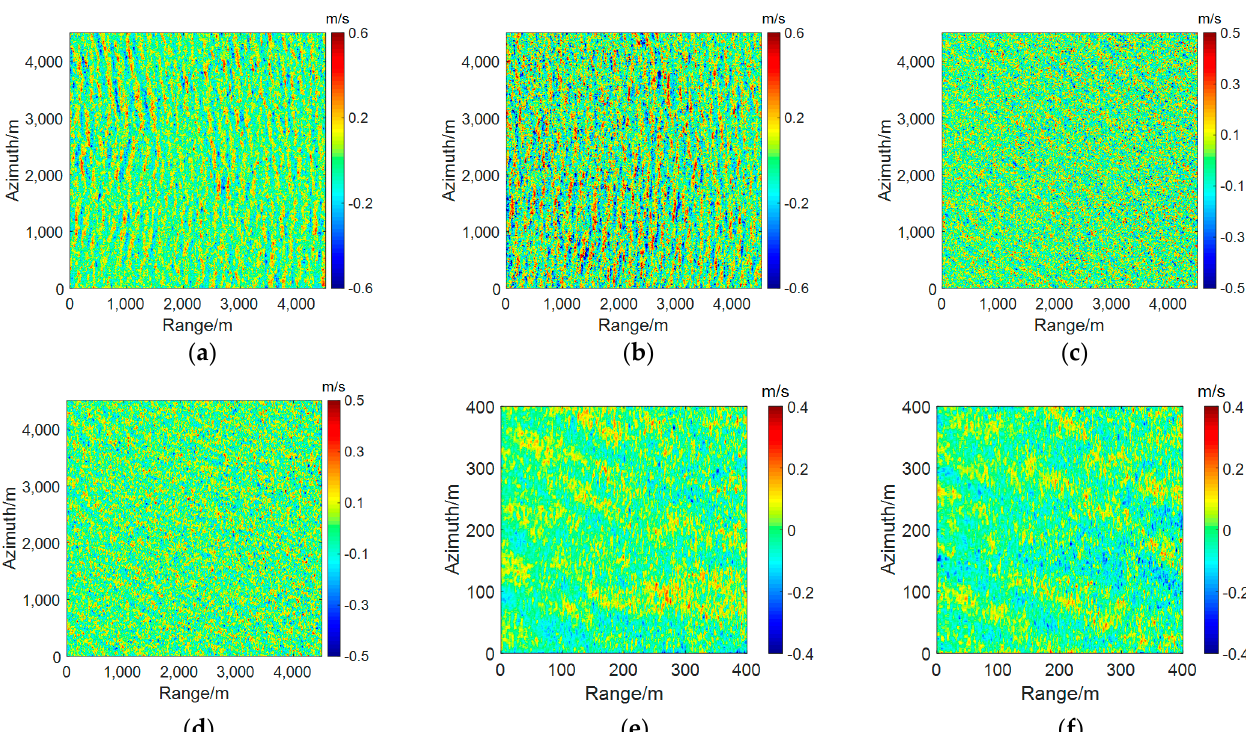
Figure 11. The retrieved orbital velocities of ocean waves from the spaceborne hybrid InSAR images and airborne hybrid InSAR images: ( a ) A 1 ; ( b ) A 2 ; ( c ) A 3 ; ( d ) A 4 ; ( e ) M920; ( f ) M3120.